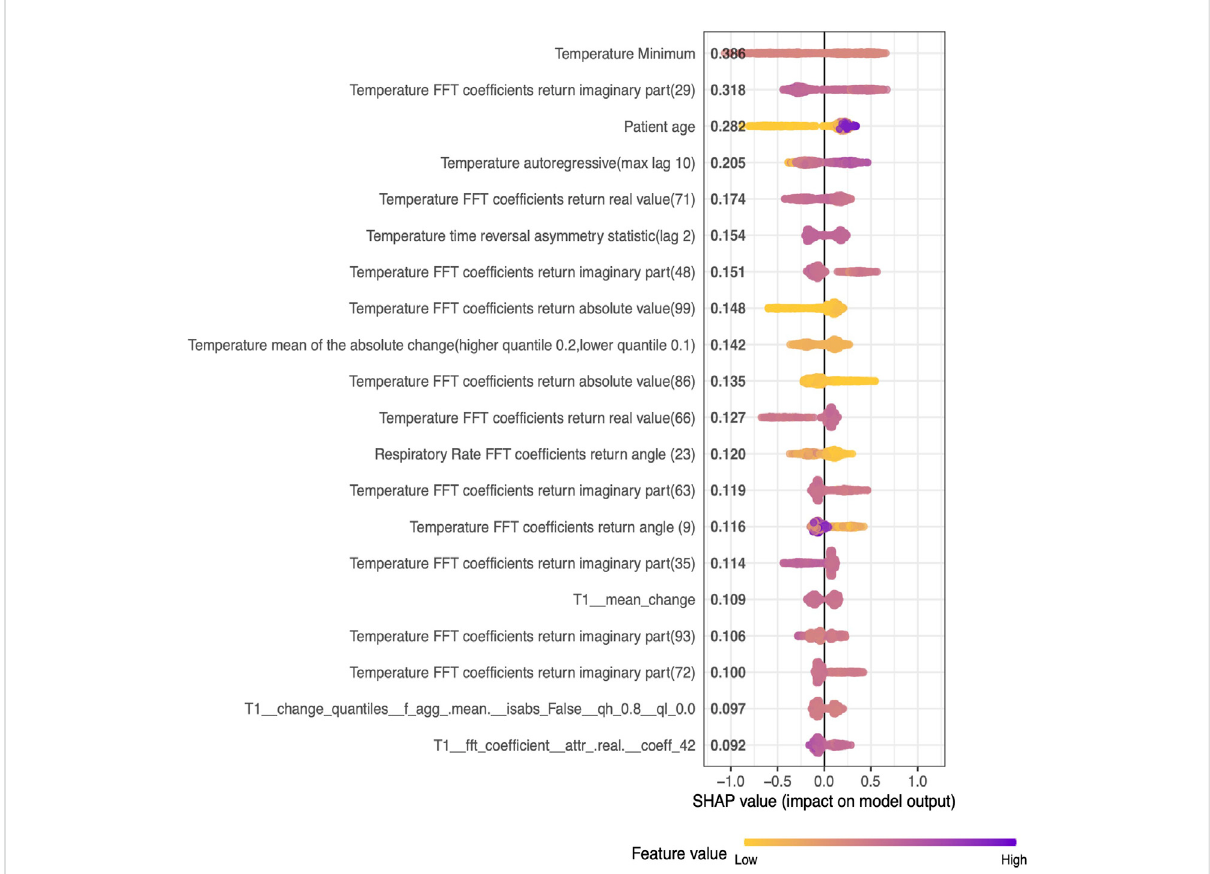
FIGURE 3 SHAP values of the top 20 Nonlinear features (descending order) generated from the fi ve-fold test set on pediatric data.